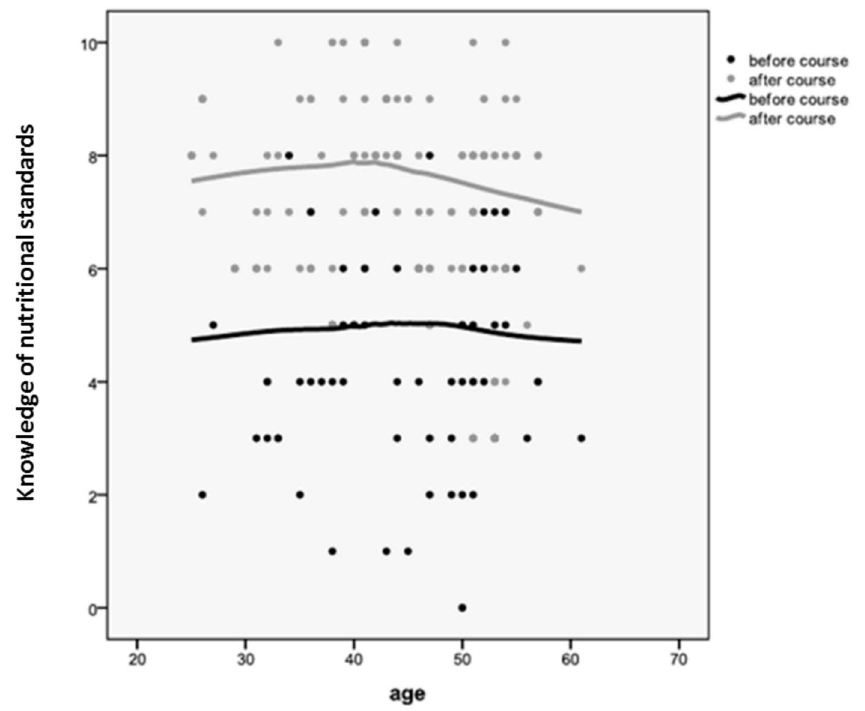
Figure 2b. Scatter plot for age of participants and knowledge of nutritional standards by time of test (including LOESS fit